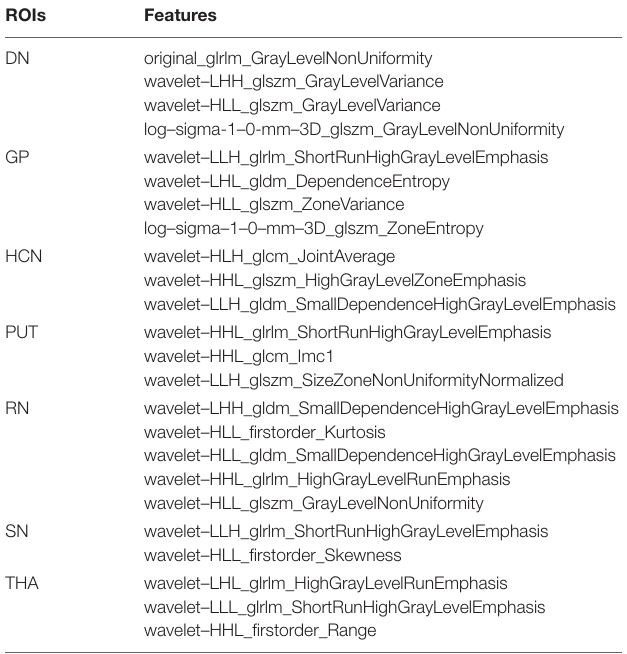
TABLE 2 | The selected radiomic features with different regions. ROIs Features